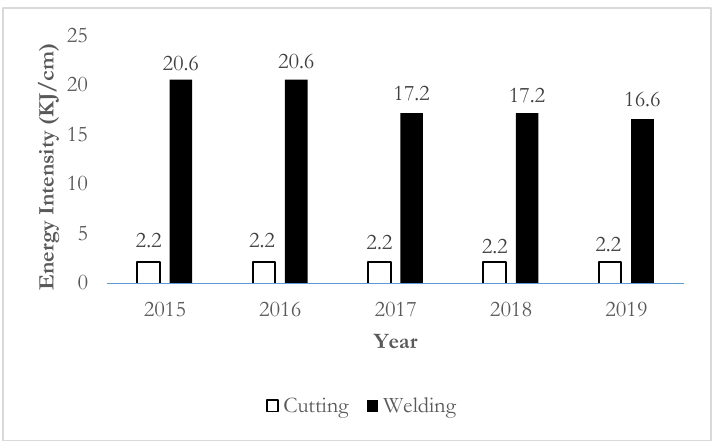
Fig. 2. Energy intensity of the pipeline construction workforce in 2015-2019.